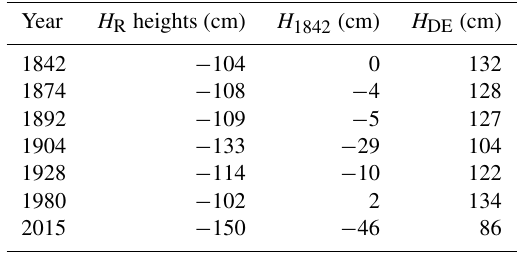
Table 2. Survey of DM heights in